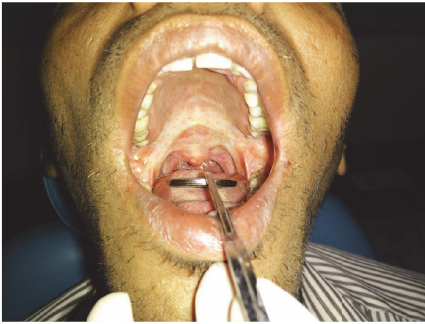
Figure5:Hockeystickshapeduvulaandtheblanchingofthepalate.